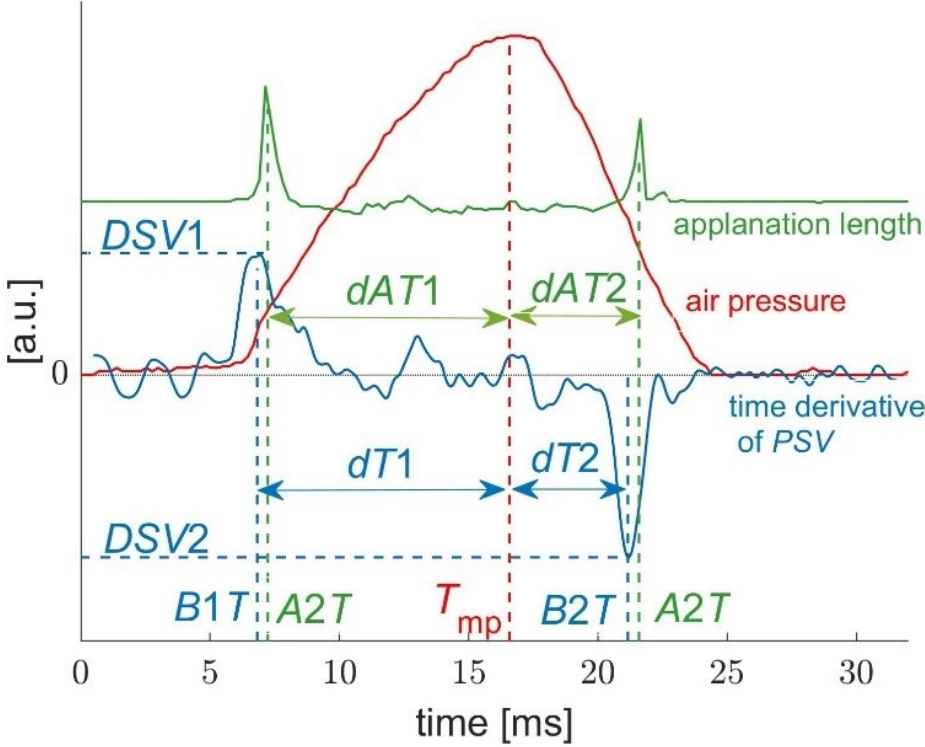
Figure 3. Three curves from an exemplary measurement (nozzle air pressure, applanation length, and the time derivative of the PSV function from Figure 2) and related parameters.